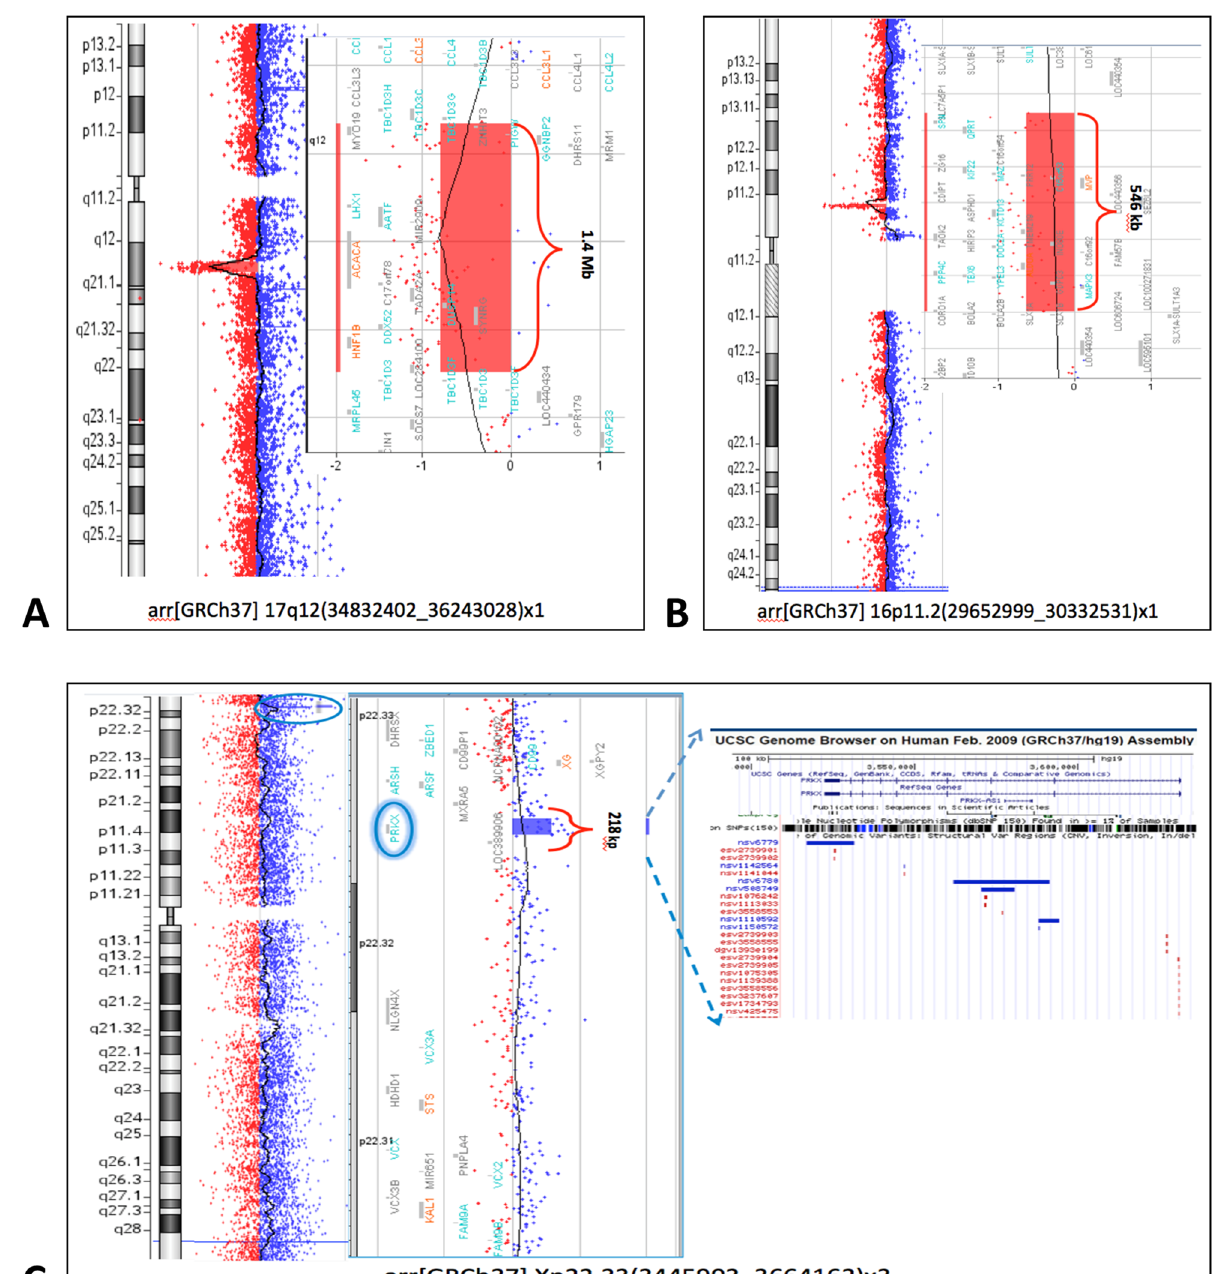
Figure 1. Array-CGH analysis (75 Kb average resolution). Profiles of chromosomes and details of CNVs generated by CytoGenomics (v5.0; Agilent) and showing (A) the microdeletion of about 1.4 Mb at 17q12 chromosome region, including LHX1 and HNFB1 candidate genes (B) the microdeletion of about 500 Kb in size at 16p11.2 chromosome region, encompassing TBX6 candidate gene (C) the microduplication of about 218 Kb at Xp22.33 chromosome region, including the new candidate-gene PRKX